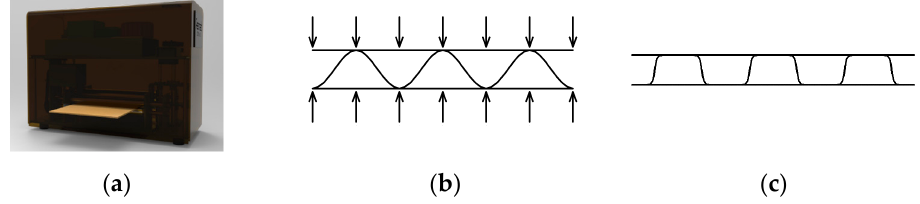
Figure 5. The cardboard crushing: ( a ) cardboard testing device; ( b ) loaded sample scheme; ( c) deformed sample scheme.